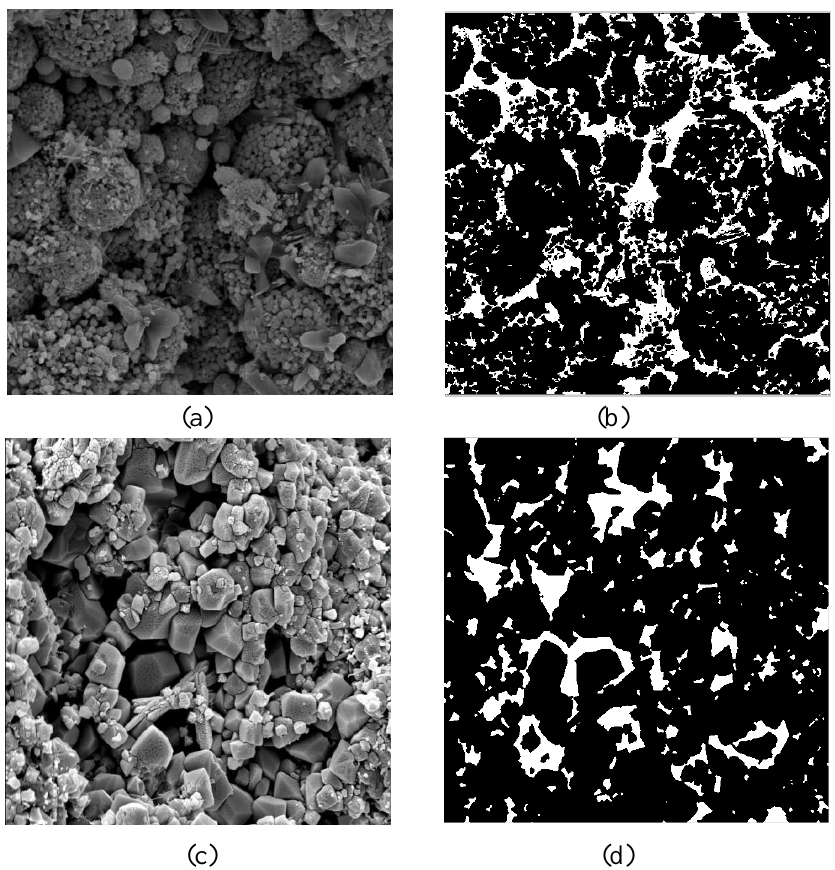
Fig. 10. SEM images for samples S 2 and S 3 (a, c) and respective segmentation results (b, d) . White pixels denote pores and black pixel denote Figure 10. SEM images for samples S